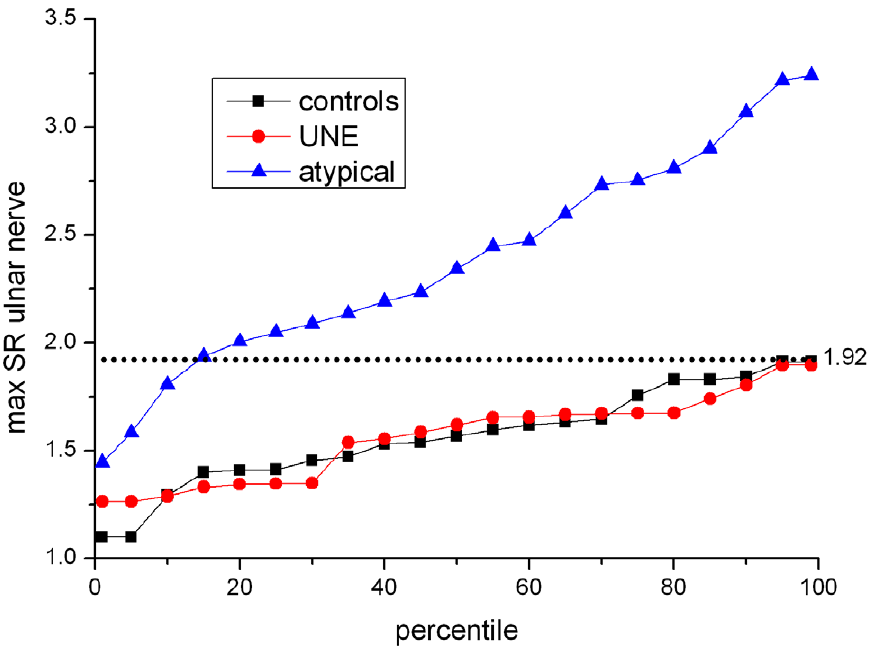
Figure 6. Percentile plot of maximum SR in proximal ulnar nerve. Percentiles for each group are plotted for maximum values of ulnar nerve- to-muscle signal intensity ratios at upper arm level. Dotted line indicates the most conservative cut-off value of 1.92 which completely excludes false- positives. The lowest value for the group with atypical proximal lesion corresponds to the case shown in figure 3.